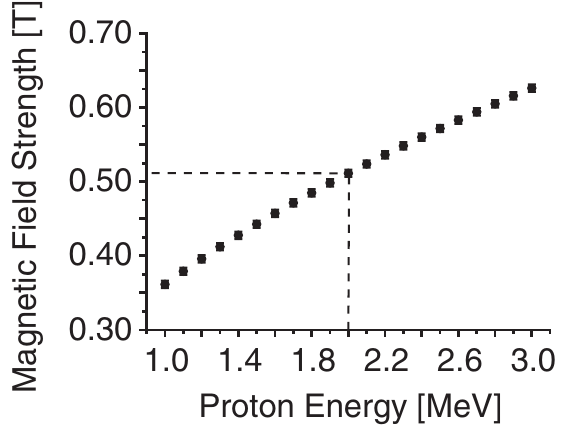
FIG. 6. Calibration curve of the monochromator, the energy of the transmitted proton beam through the slit vs the magnetic field strength of the bending magnet.